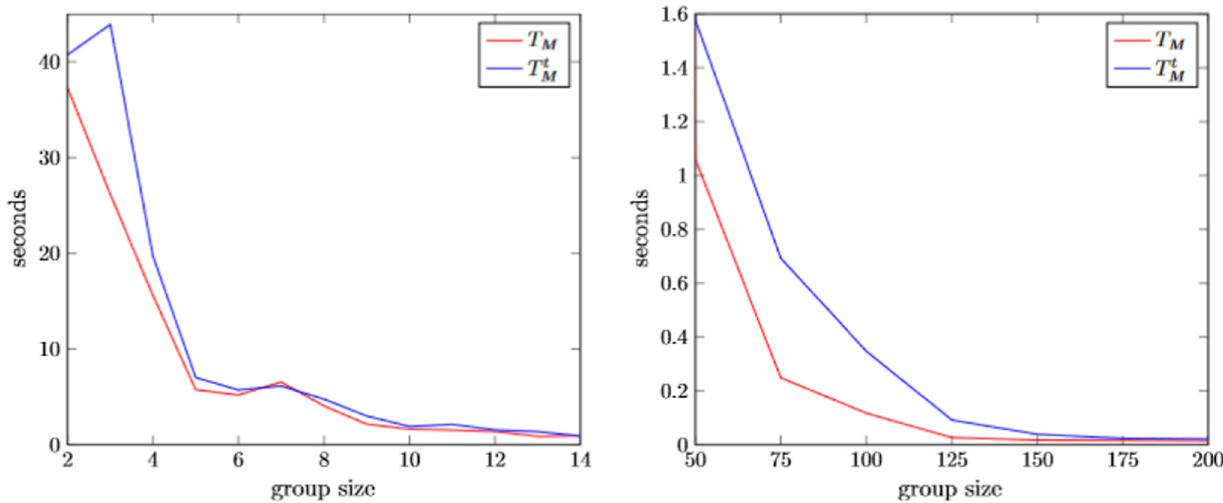
Fig. 2 Comparison of the MaxSAT transformations T M and T t